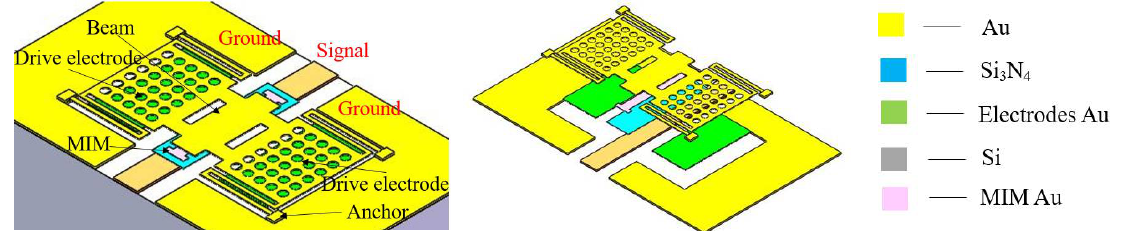
Figure 1. Switch diagram. Adapted with permission from ref. [16]. Copyright 2020, Springer